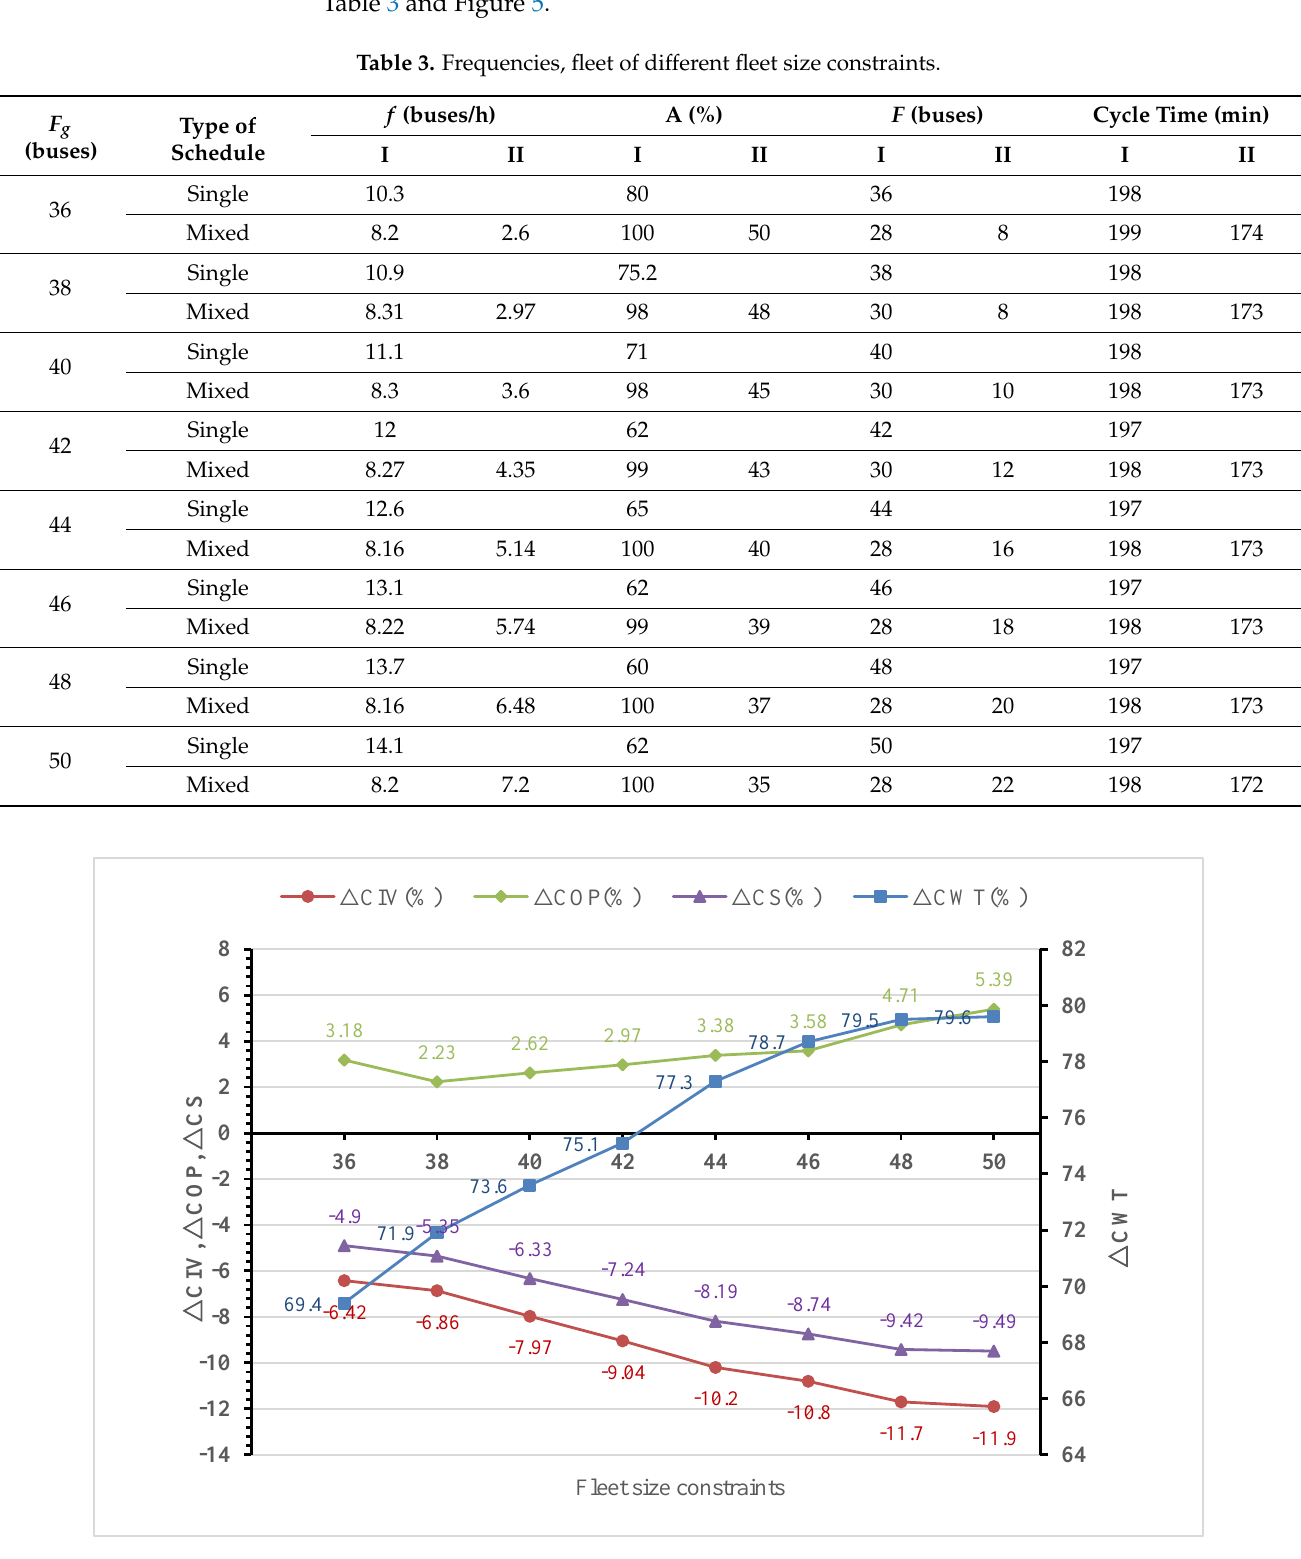
Figure 5. The waiting time cost, in-vehicle time cost, operation cost and total cost of different fleet size constraints. * △ CWT(%), △ CIV(%) and △ COP(%) mean the percentage increase of mixed schedule to single schedule of waiting time cost, in-vehicle time cost, and operation cost, respectively.